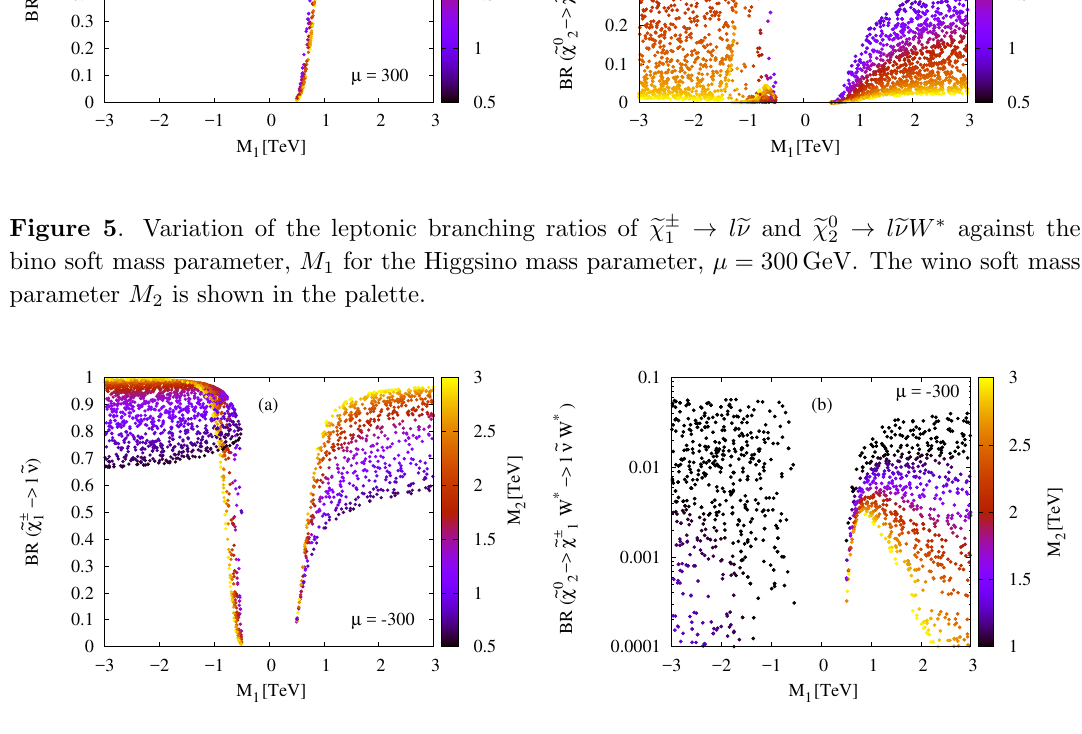
(cid:31) (cid:6) ! l (cid:23) and (cid:31) 0 ! l (cid:23)W (cid:3) against the e e e e 2 1